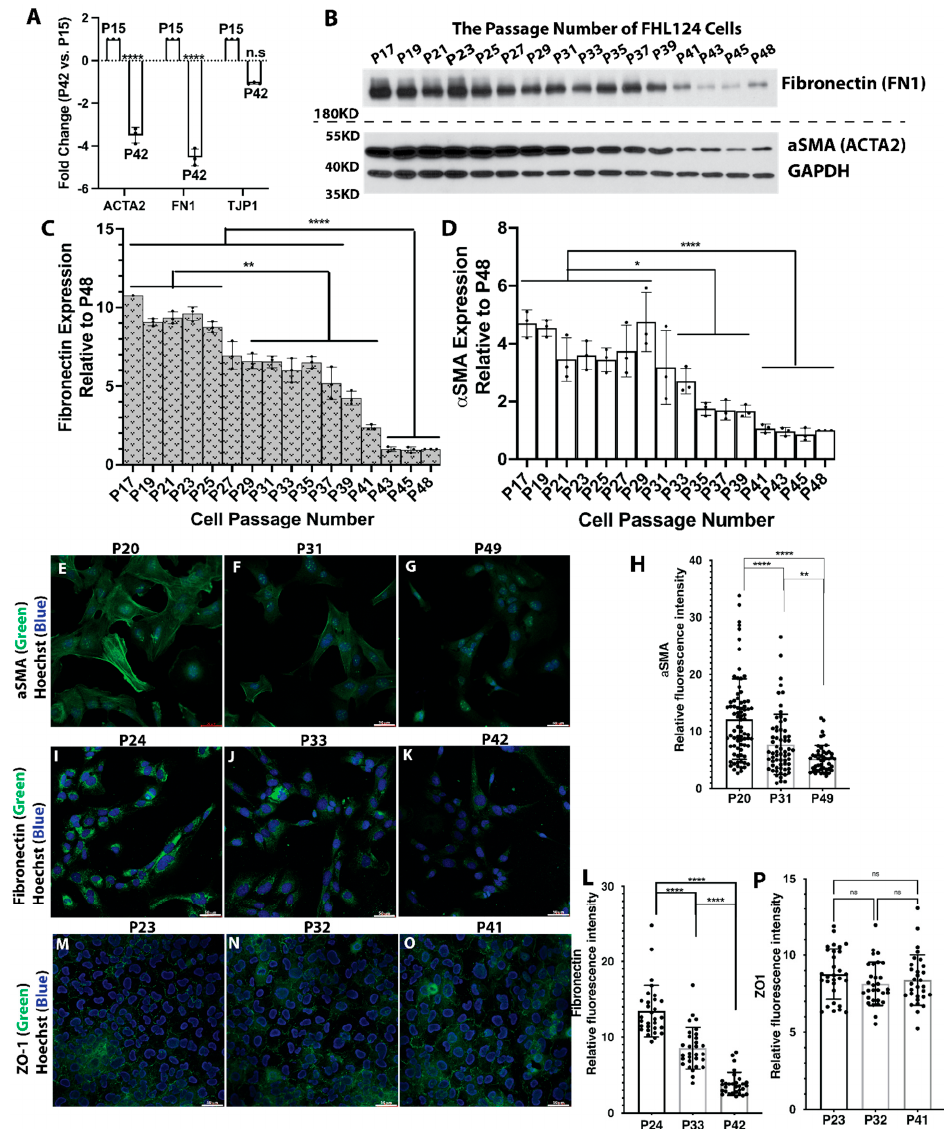
Figure 4. Fibronectin and α SMA protein expression gradually decreased in LECs aging. ( A ) Relative mRNA expression of fibronectin and α SMA between P42 and P15 passage FHL124 cells. Data are expressed as fold change relative to P15. ( B ) Fibronectin and α SMA protein levels from passage 17 to passage 48 FHL124 cells (n = 3). GAPDH serves as a loading control. ( C ) Semi-quantitative results of fibronectin expression from immunoblot ( B ) (n = 3). ( D ) Semi-quantitative results of α SMA expression from immunoblot ( B ) (n = 3). ( E – P ) immunofluorescence staining of fibronectin, α SMA, and ZO-1 protein expression in early, middle, and late passage LECs. ( E – G ) α SMA IF: α SMA (green), nuclei (blue) by Hoechst 33342. ( E ) Passage 20. ( F ) Passage 31. ( G ) Passage 49. ( I – K ) Fibronectin IF: fibronectin (green), nuclei (blue). ( I ) Passage 24. ( J ) Passage 33. ( K ) Passage 42. ( M – O ) ZO-1 IF: ZO-1 (green), nuclei (blue). ( M ) Passage 23. ( N ) Passage 32. ( O ) Passage 41. ( H ) Quantitative results of α SMA protein expression based on fluorescence intensity. Fluorescence intensity from 50 cells was measured. ( L ) Quantitative results of fibronectin protein expression based on fluorescence intensity. Fluorescence intensity from 50 cells was measured. ( P ) Quantitative results of ZO-1 protein expression based on fluorescence intensity. Fluorescence intensity from 50 cells was measured. Results are expressed as mean ± SD and were analyzed using one-way ANOVA with Tukey’s multiple comparisons test. Only p < 0.05 is considered significant. * < 0.05, ** < 0.01, *** < 0.001, **** < 0.0001; n.s, not